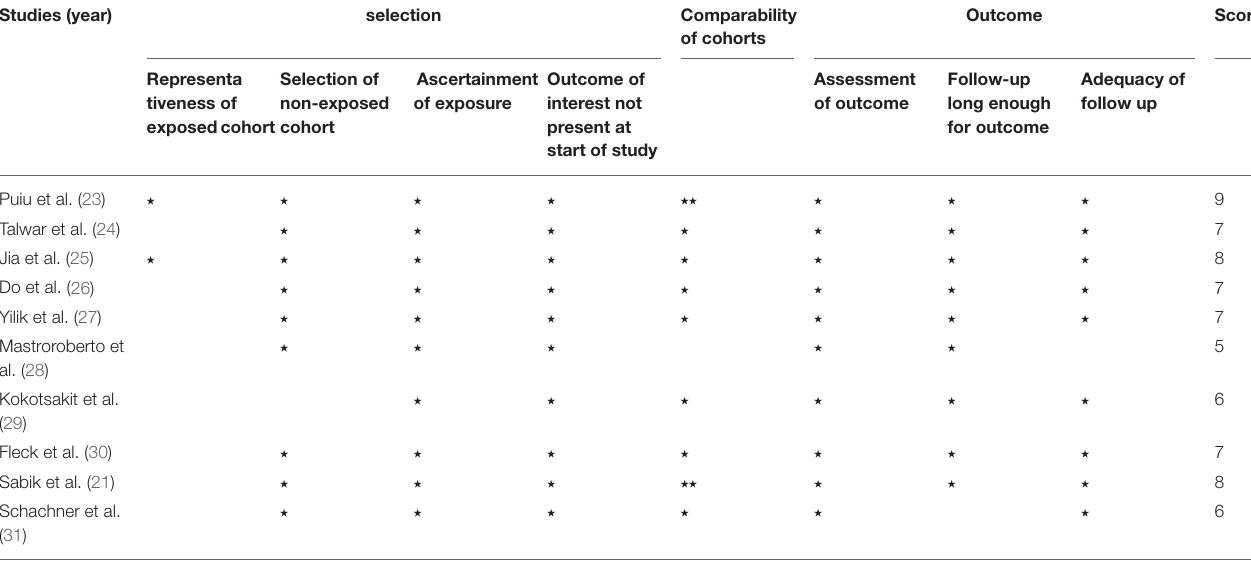
TABLE 1 | Newcastle-Ottawa quality assessment of ten eligible studies. Studies